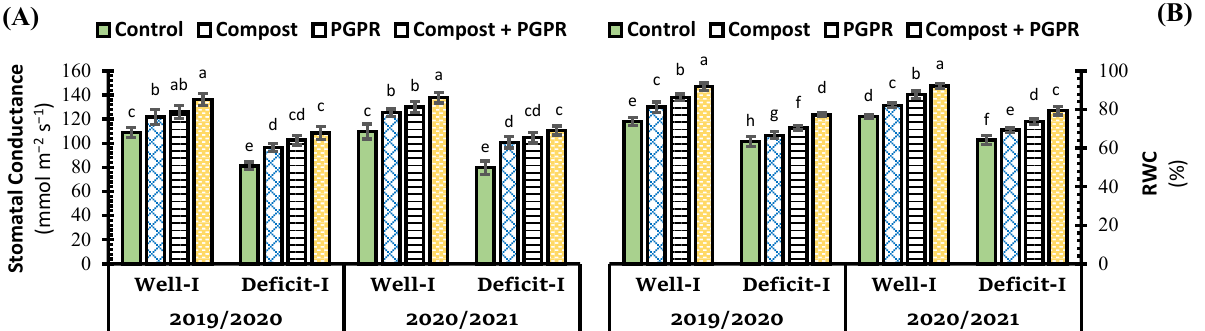
Figure 2. Influence of soil amendment with compost and plant growth-promoting rhizobacteria (PGPR) on ( A ) stomatal conductance, and ( B ) relative water content (RWC) in the leaves of wheat plants grown in salt-affected soil and deficit irrigation in contrast to well irrigation. The error bars present the values of standard deviation. According to Duncan’s multiple range test, the same lower-case letters above columns are not significantly different ( p < 0.05).